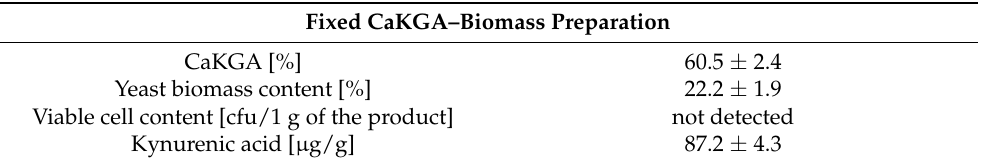
Table 5. Characteristics of the fixed CaKGA–biomass preparation obtained from the culture